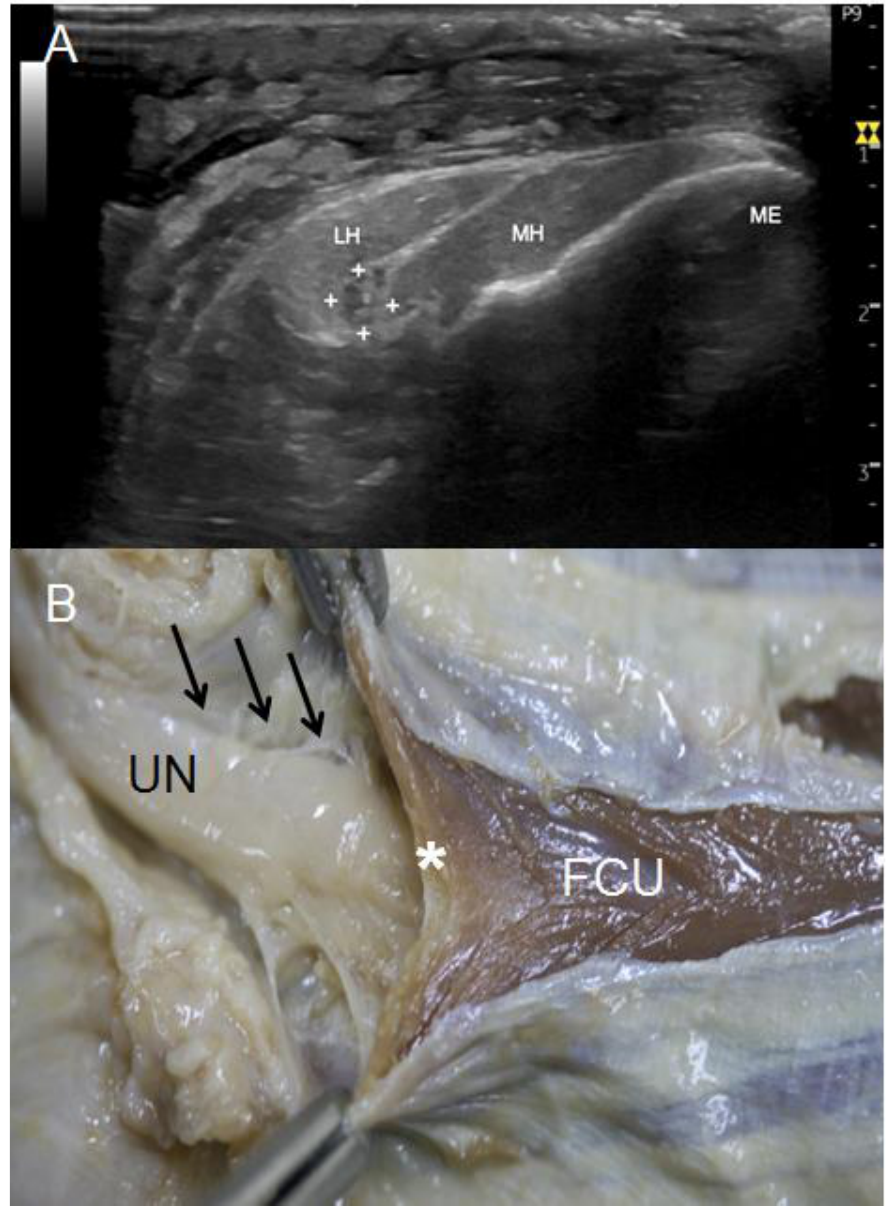
Figure 7. ( A ) US view of UN (white crosses) at its exit from the osteofibrous tunnel of the elbow, crossing between medial (MH) and lateral (LH) heads of flexor carpi ulnaris. ( B ) Anatomical view of the UN at this point. It is shown how it crosses beneath the Osborne’s ligament (white asterisk), which connects both heads of the flexor carpi ulnaris (FCU). In addition, note that the UN remains attached to the FCU’s epimysium (black